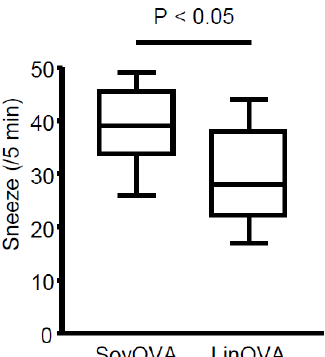
Figure 1. Dietary linseed oil reduces allergic rhinitis responses in mice. Mice were maintained on a diet containing 4% soybean oil (Soy) or linseed oil (Lin). After 2 months, ovalbumin (OVA)-induced allergic rhinitis was induced, and the sneezing rate was calculated. Data are from three